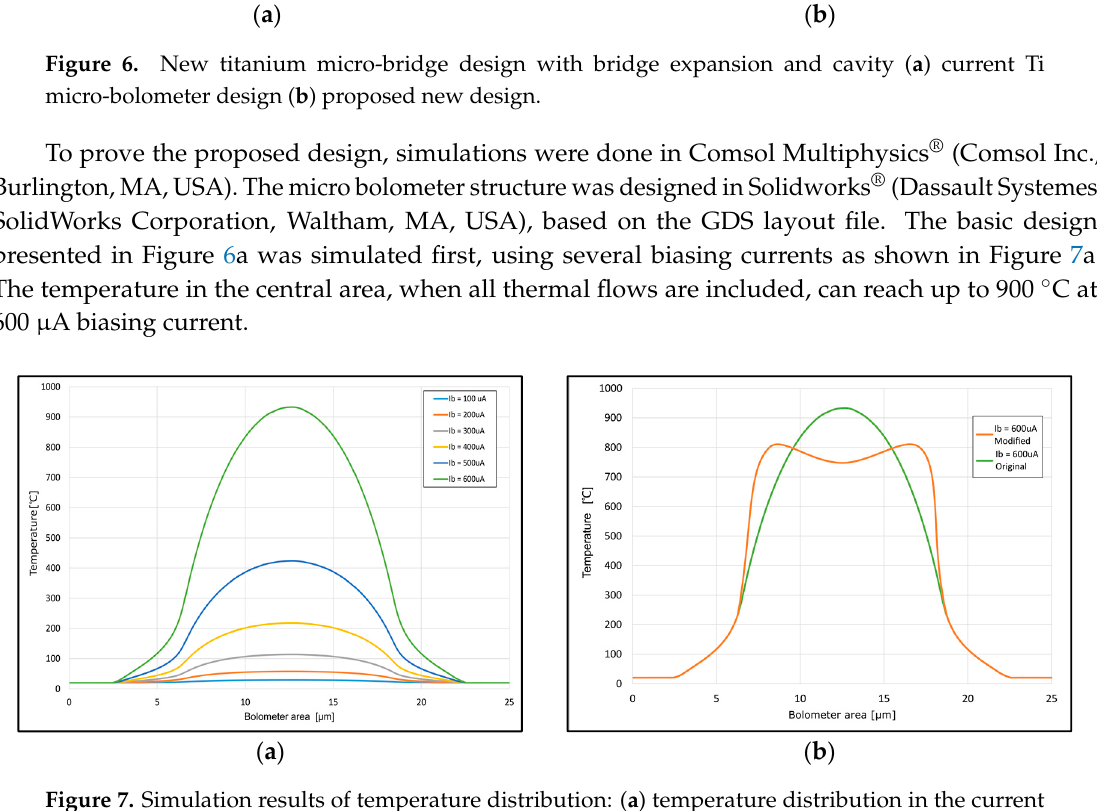
Figure 7. Simulation results of temperature distribution: ( a ) temperature distribution in the current micro-bolometer design at different biasing currents, ( b ) temperature distribution of current and proposed micro-bolometer design at 600 µA biasing current.